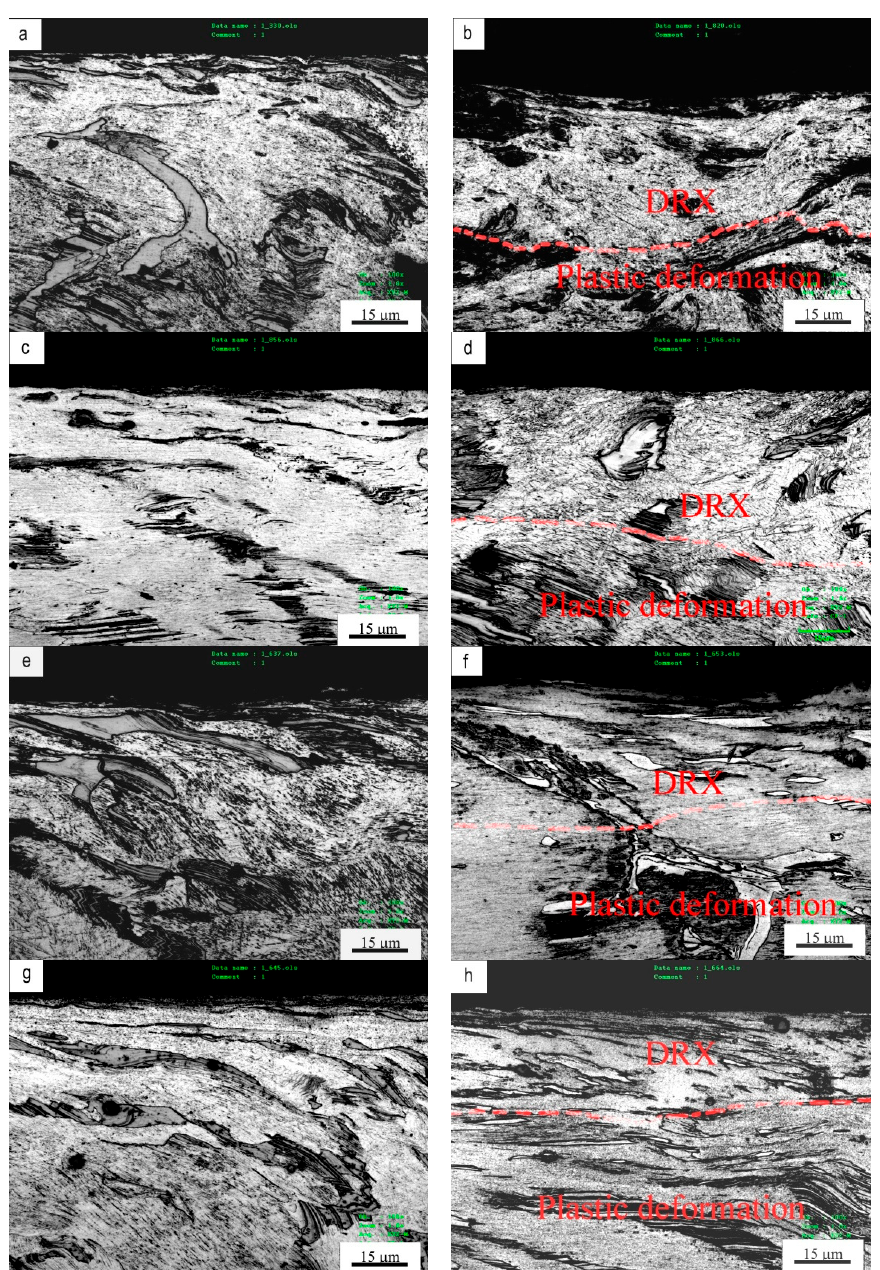
Figure 7. Subsurface microstructures under different sliding conditions: ( a ) 70 N, 100 °C, ( b ) 140 N, 100 °C, ( c ) 40N, 200 °C, ( d ) 100 N, 200 °C, under 0.8 m/s; ( e ) 20 N, 100 °C, ( f ) 60 N, 100 °C, ( g ) 20 N, 200 °C, ( h ) 40 N, 200 °C, under 3.0 m/s.